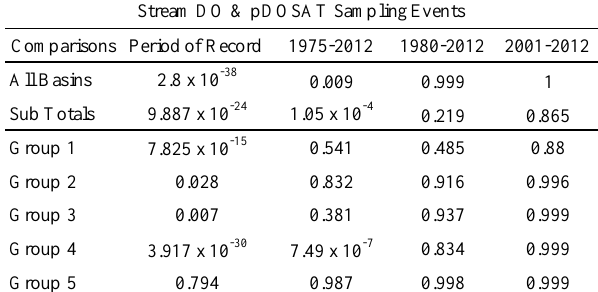
Table 4. Stream DO & pDOSAT Chi Square test for Independence. Test was conducted at various spatial and temporal scales.